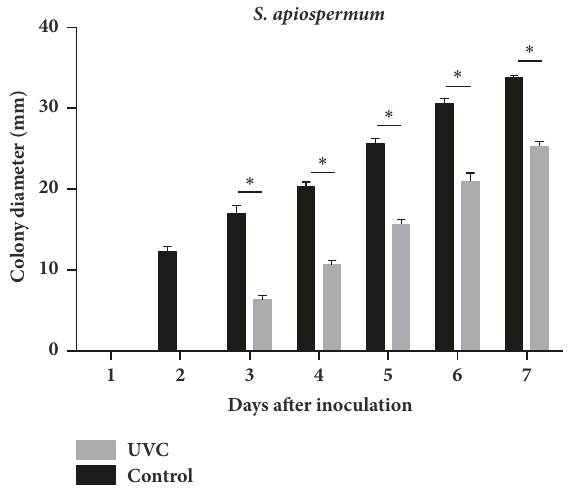
Figure 3: The growth kinetic of S. apiospermum CBS 117410 after 15 min of UVC exposure.